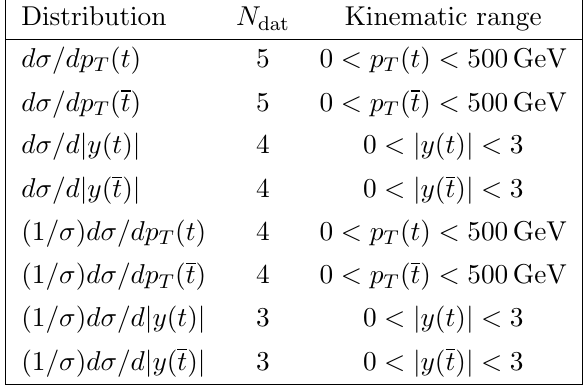
Table 2 . The ATLAS measurements [12] of t -channel single top-quark and top-antiquark di(cid:11)er- ential cross sections at a centre-of-mass energy of 7 TeV studied here. Distributions are a function of the top-quark (top-antiquark) transverse momentum, p T ( t ) ( p T ((cid:22) t )), and absolute rapidity, j y ( t ) j ( j y ((cid:22) t ) j ). The bin edges for the transverse momentum distributions are 0, 45, 75, 110, 150 and 500 GeV, while for the rapidity distributions they are 0, 0.2, 0.6, 1.1 and 3.0. For each distribution, we indicate the number of bins, N dat , and their overall kinematic